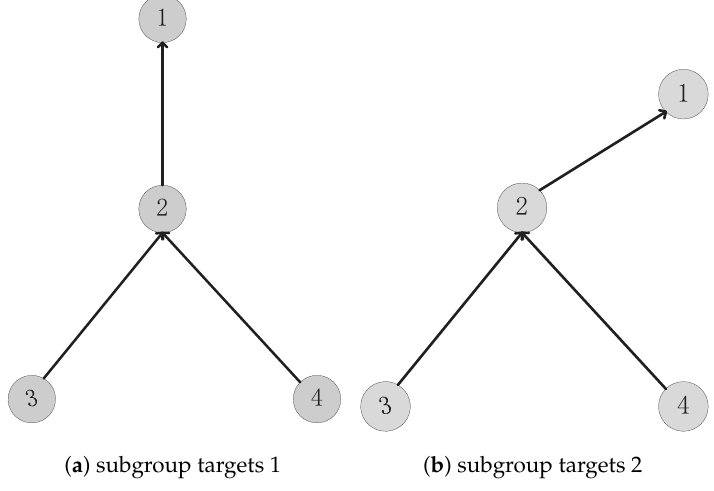
Figure 1. Two group targets with the same